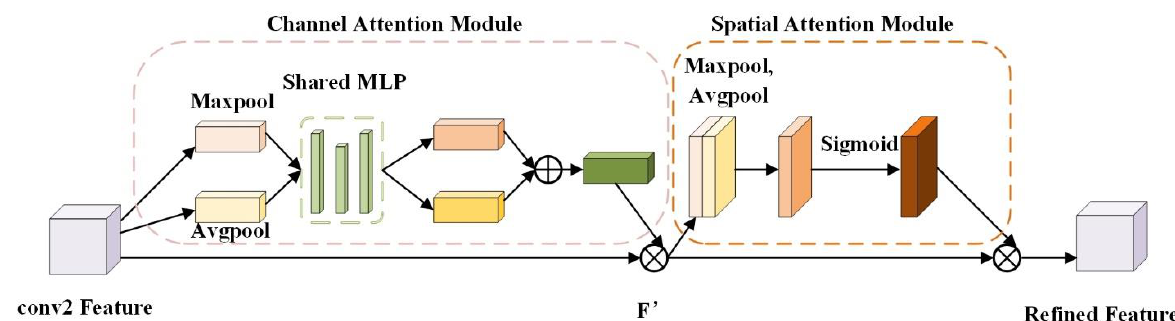
Figure 5. Structure of DFE